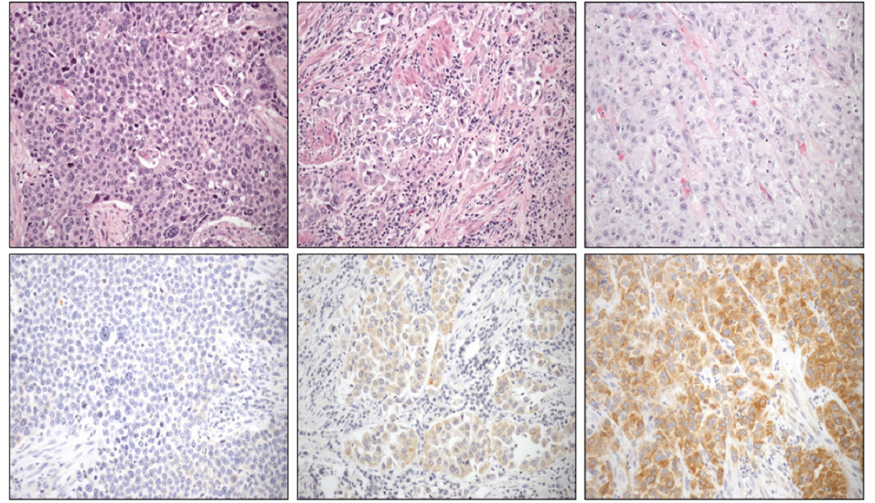
Figure 1. High-grade urothelial carcinomas with their respective prorenin immunostaining (lower row) quantified as absent ( left ), weak ( middle ), and intense ( right ) (original magnification in all cases × 250).